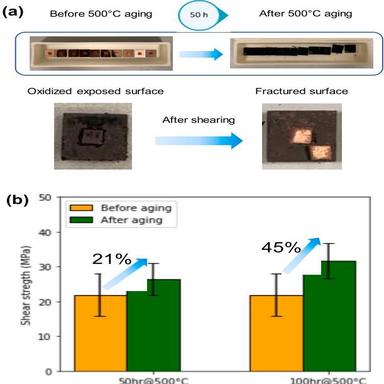
(a) Optical images of the sintered Cu/nanoCu/Cu joints after thermal aging at 500 ◦C for 50 h. (b) Shear strength of the sintered Cu/nanoCu/Cu joints after thermal aging at 500 ◦C for 50 and 100 h, respectively.